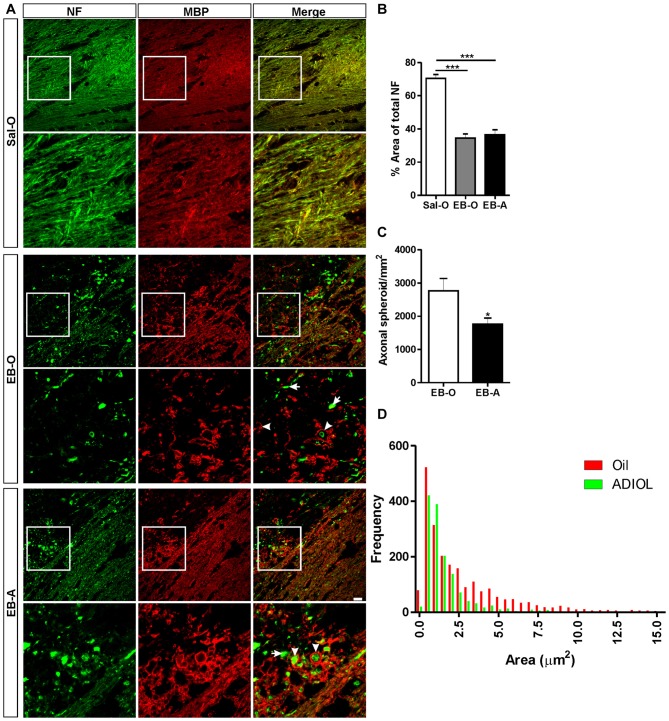
Effect of androstenediol (ADIOL) on axonal damage 2 days post-ethidium bromide (EB)-induced demyelination. (A) Immunofluorescent staining of neurofilament (NF, green) and myelin basic protein (MBP, red) in the corpus callosum of Sal-O, EB-O or EB-A rat groups. Injection of EB into the corpus callosum (EB-O panel) decreased the density of NF+ fibers when compared to that seen in saline-injected group (Sal-O panel). Systemic injection of ADIOL increased the density of NF+ fibers in the vicinity of the demyelinated corpus callosum (EB-A panel) compared to the one seen in EB-O rat group. At the edge of the demyelination lesion, many of NF+ axons in EB-O rat group either lacked myelin (arrows) or had a detached myelin sheath (arrowheads). In contrast, the axons of EB-A rat group had more compact myelin sheaths (arrowheads). (B) Bar graph shows the percentage area covered by NF+ fibers in the three rat groups (Sal-O: n = 4, EB-O: n = 4, EB-A: n = 6). EB injection induced a significant decrease in the area covered by NF+ fibers when compared to NF+ density in saline-injected animals (p < 0.001). This decreased axonal density was not affected by systemic injection of ADIOL. (C) Bar graph presents the number of axonal spheroids in the vicinity of the demyelination lesion in EB-O and EB-A groups. ADIOL significantly reduced the number of axonal spheroids compared to oil-treated animals (EB-O: n = 4, EB-A: n = 6, p < 0.05). (D) Histogram shows the frequency distribution of axonal spheroids according to their sizes. The majority of axonal spheroids had a size less than 2.5 μm2 in both EB-O and EB-A rat groups. *p < 0.05, ***p < 0.001. All data are presented as mean ± SEM. Scale bar = 50 μm.